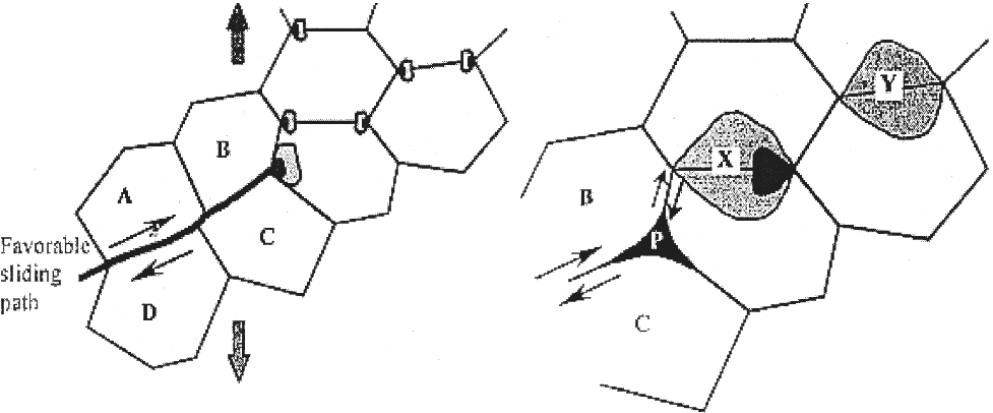
Figure 12. General model for the formation of cavity